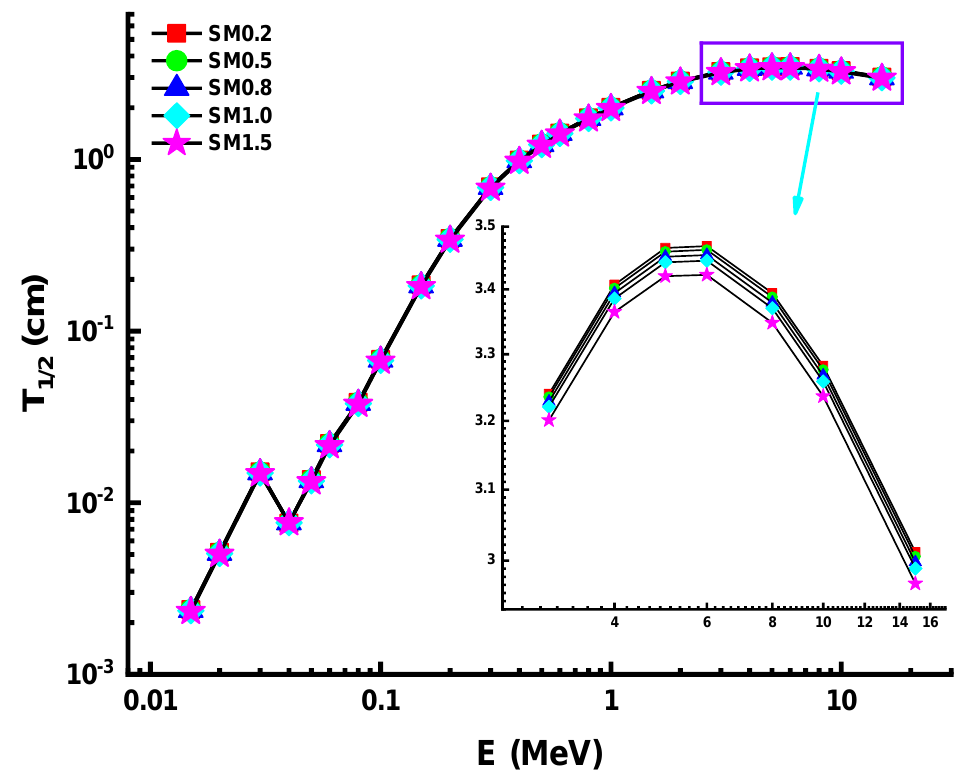
Figure 7. Variation of half value layer (T 1/2 ) against Photon energy for all glasses. As with pure elements, the atomic numbers of compounds, alloys, and composite materials cannot be represented by a single number in the various energy zones. This number is referred to as the effective atomic number (Z eff ) for compounds, alloys, and mixtures, and it changes according to the photon energy [26]. Figure 8 depicts the varia- tion of Z eff as a function of incident photon energy at all energies. The results indicated that the sample with the highest Zeff value is SM1.5, with the most Sm 2 O 3 in the structure. However, no sharp differences were reported due to the structural similarities between the samples. It should be noted that the minimum difference for Z eff values was reported as 0.07 at 0.04 MeV, whereas the maximum difference was 0.36 at 0.06 MeV.